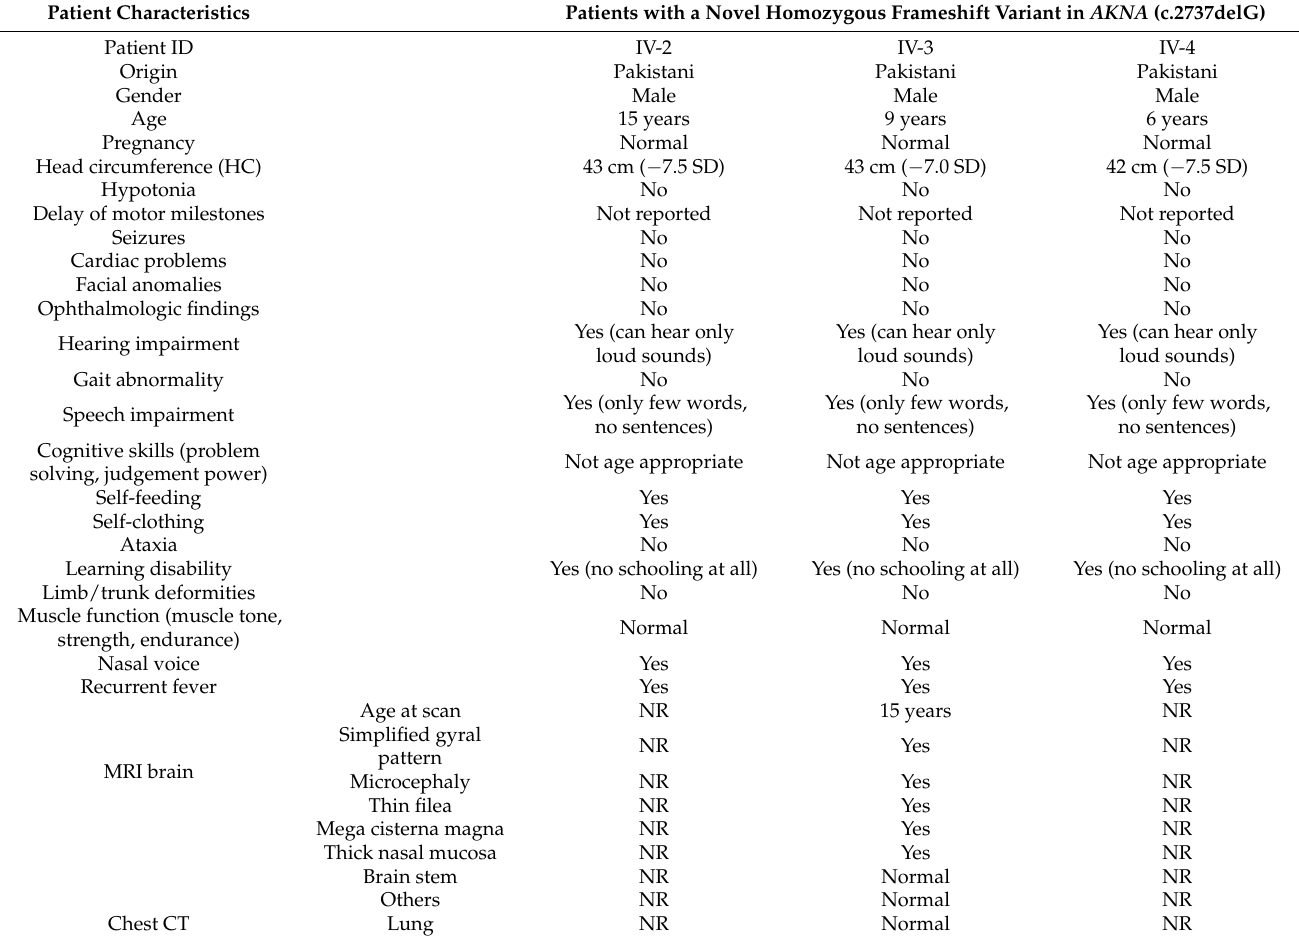
Table 1. Survey of clinical